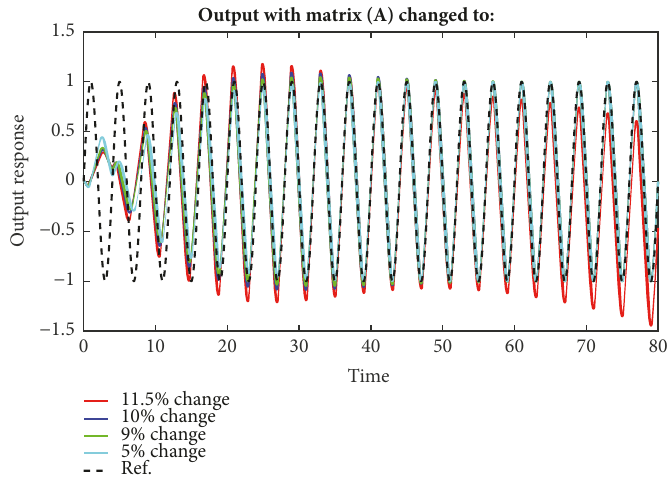
Figure 8: Output responses with dynamic matrix ( 𝐴 ) variations and 𝑤𝑓